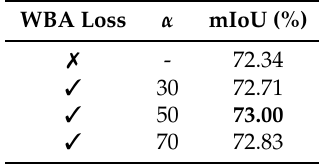
Table 3. Performance comparison with and without weighted boundary-aware loss.